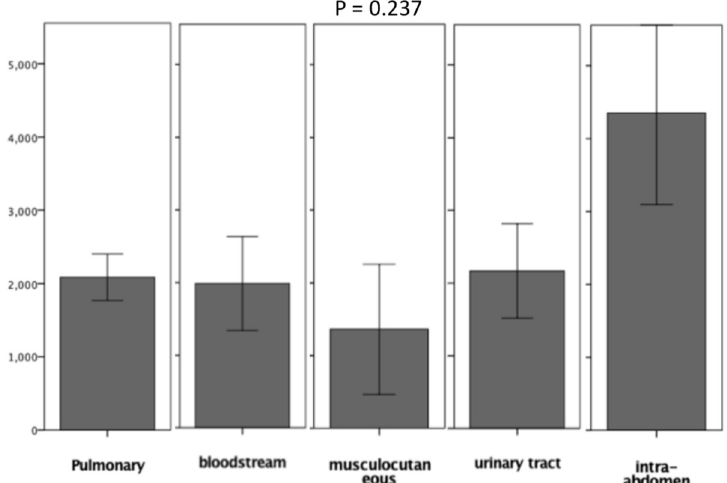
Fig 6. 72-hr cumulative fluid balance (CFB) between patients with infections of various origin. Similar 72-hr CFB values were observed in patients with sepsis originating from intra-abdominal infection (4939.4 ± 1256.7 ml), urinary tract infection (2167.4 ± 648.2 ml), pulmonary infection (2086.3 ± 317.3 ml), bloodstream infection (1986.8 ± 645.1ml), and soft tissue infection (1360.9 ± 895.8ml) (p = 0.273 using